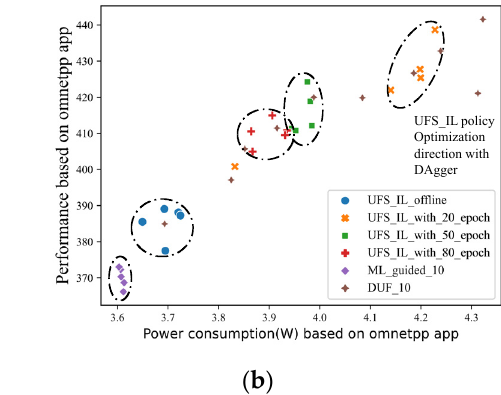
Figure 7. Performance and power consumption data distribution for unseen benchmark apps with different advanced UFS policies and UFS_IL policies with different amounts of aggregation data: ( a ) parest app; ( b ) omnetpp app.